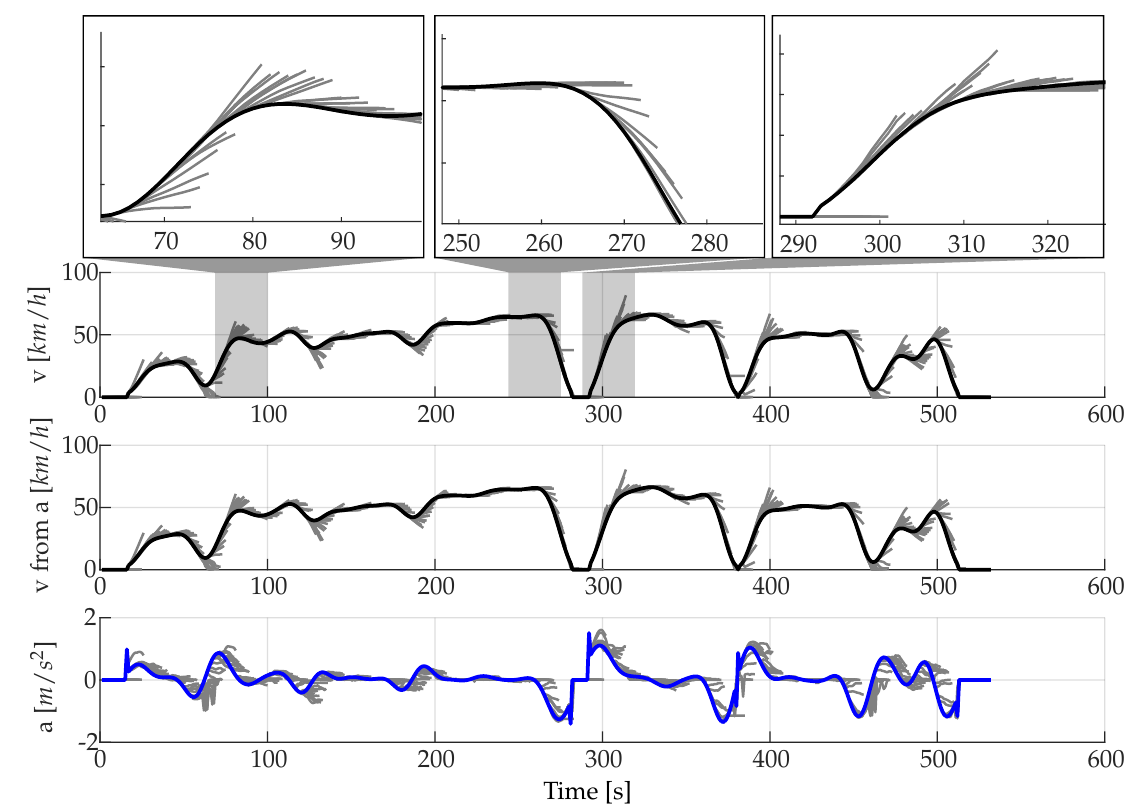
Figure 9. Predictions using MC without slope [Driver 1/10 s prediction